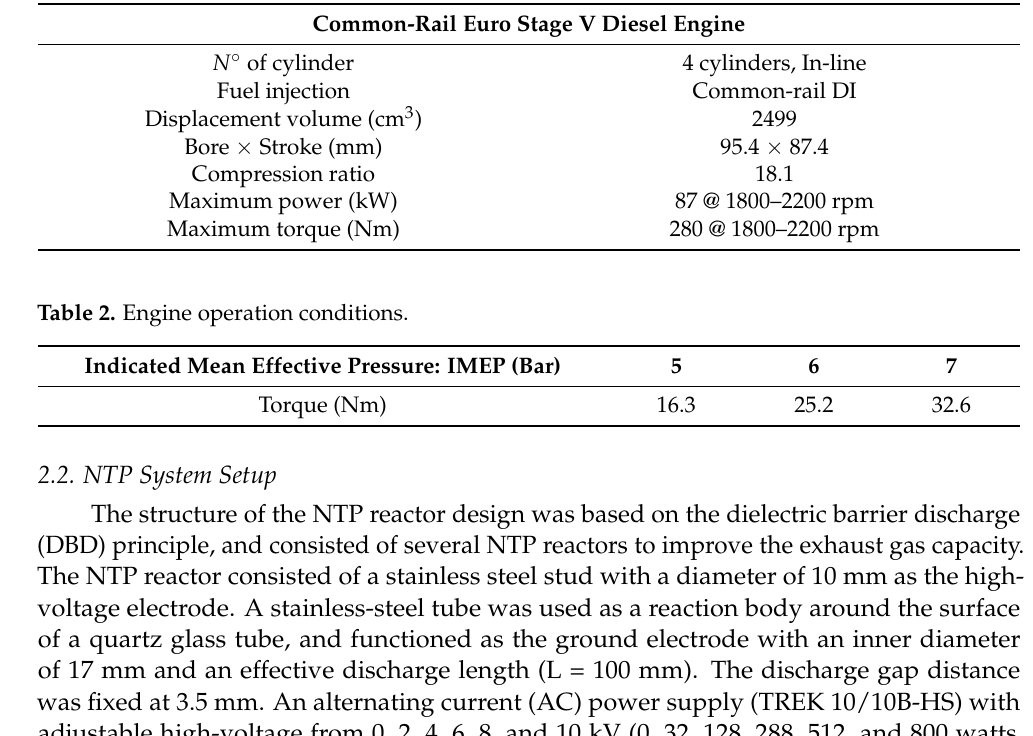
Table 1. Engine specifications.